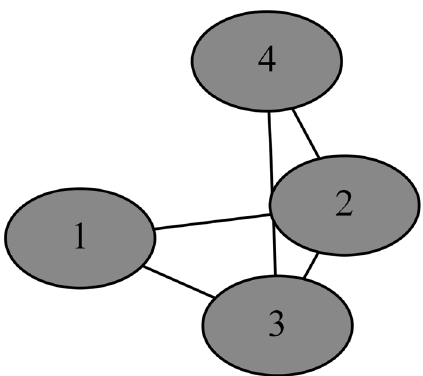
Figure 12. The PNG generated using Graphviz’s neato utility.